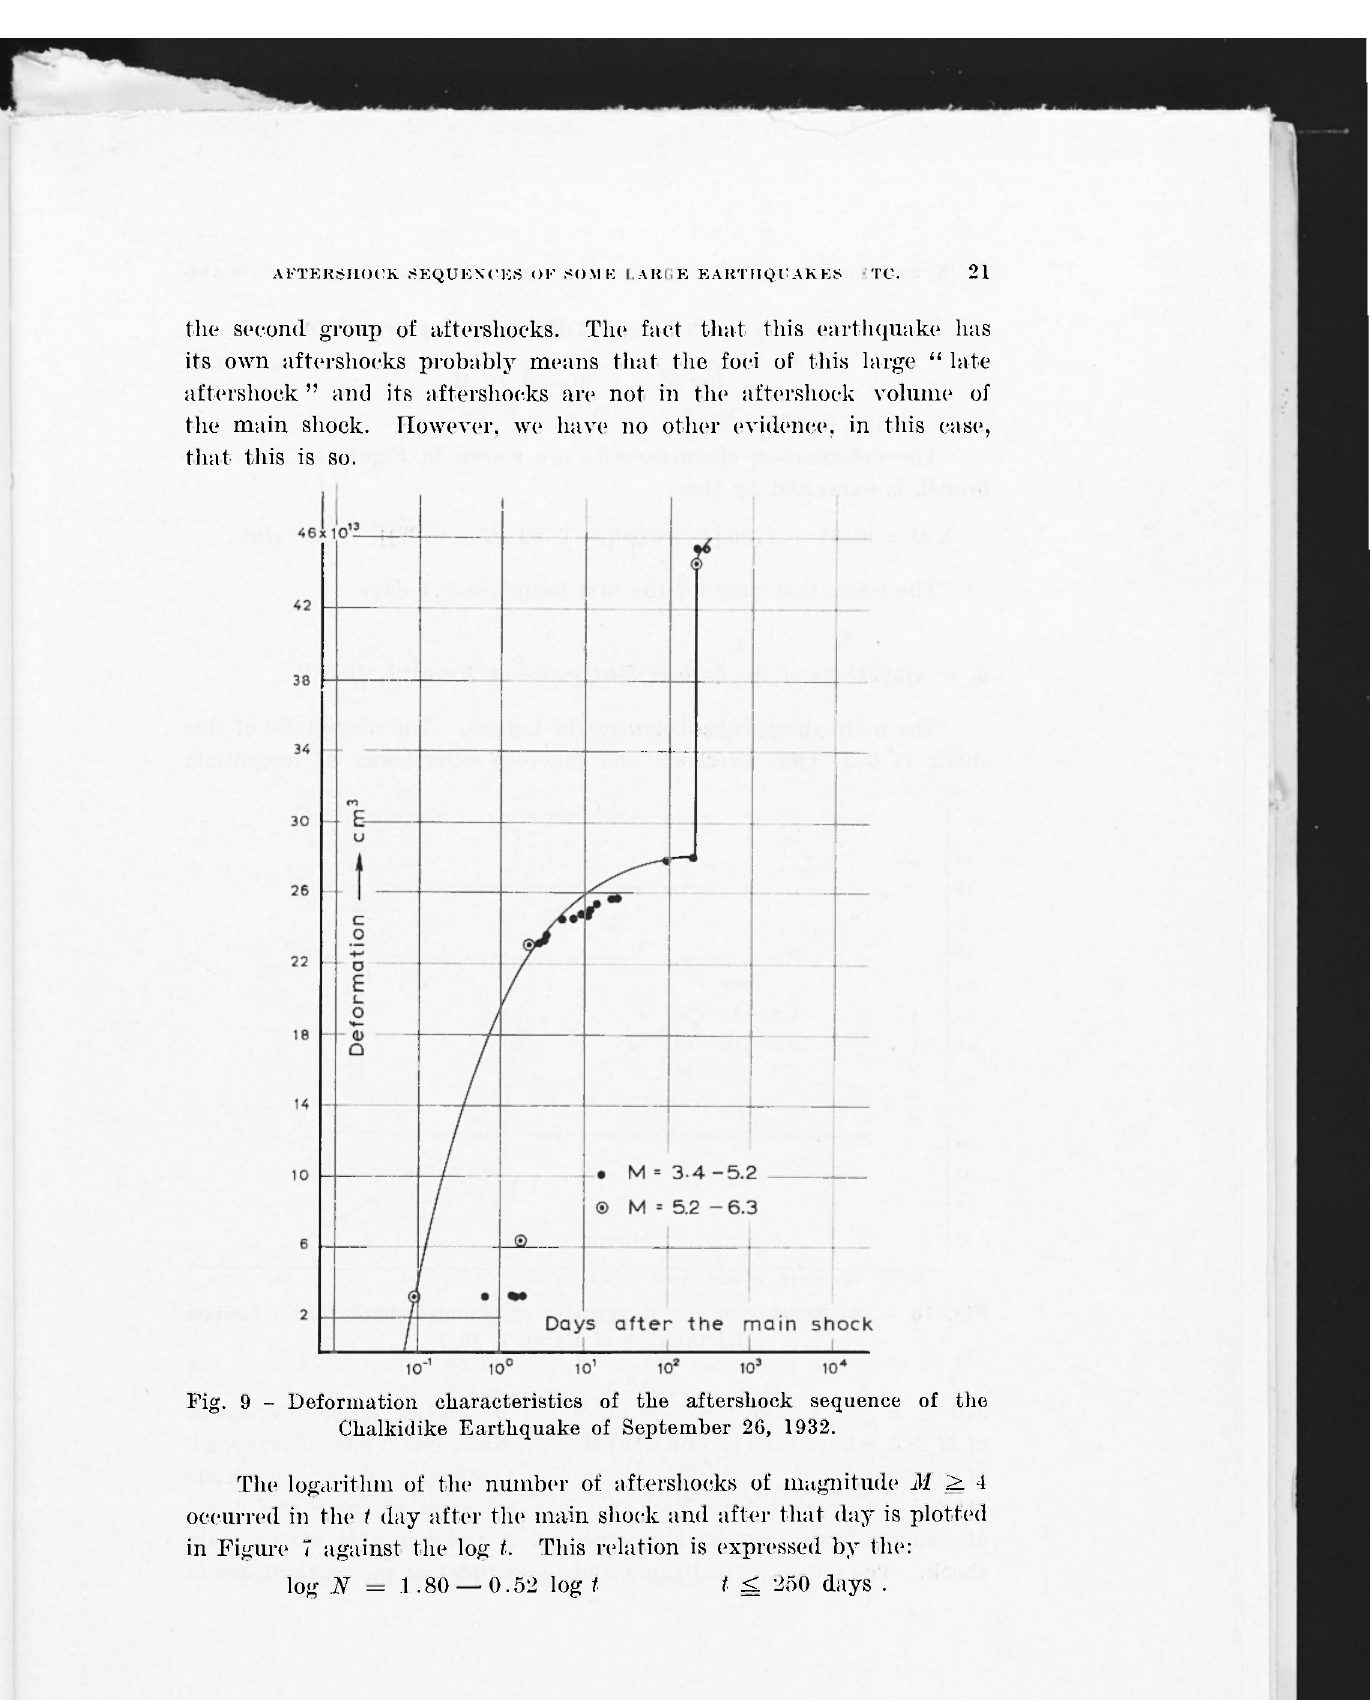
Fig. 9 - Deformation characteristics of the aftershock sequence of the Chalkidike Earthquake of September 26,